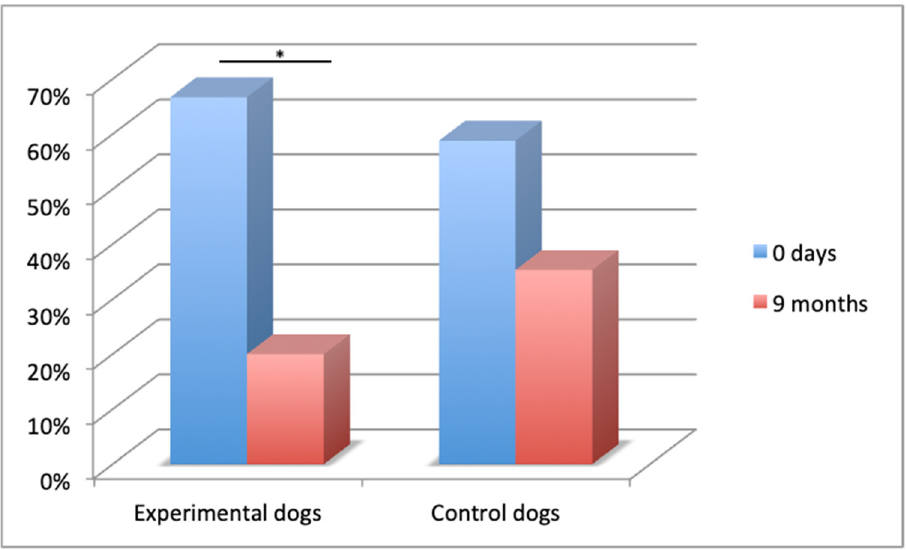
Figure 1. Mounting behavior in the two groups of males across time (* p ≤ 0.05). Table 4. Behaviors that changed across time between groups. * Owner-directed aggression showed a tendency to decrease in the experimental group (Z= − 1.890; p = 0.059).